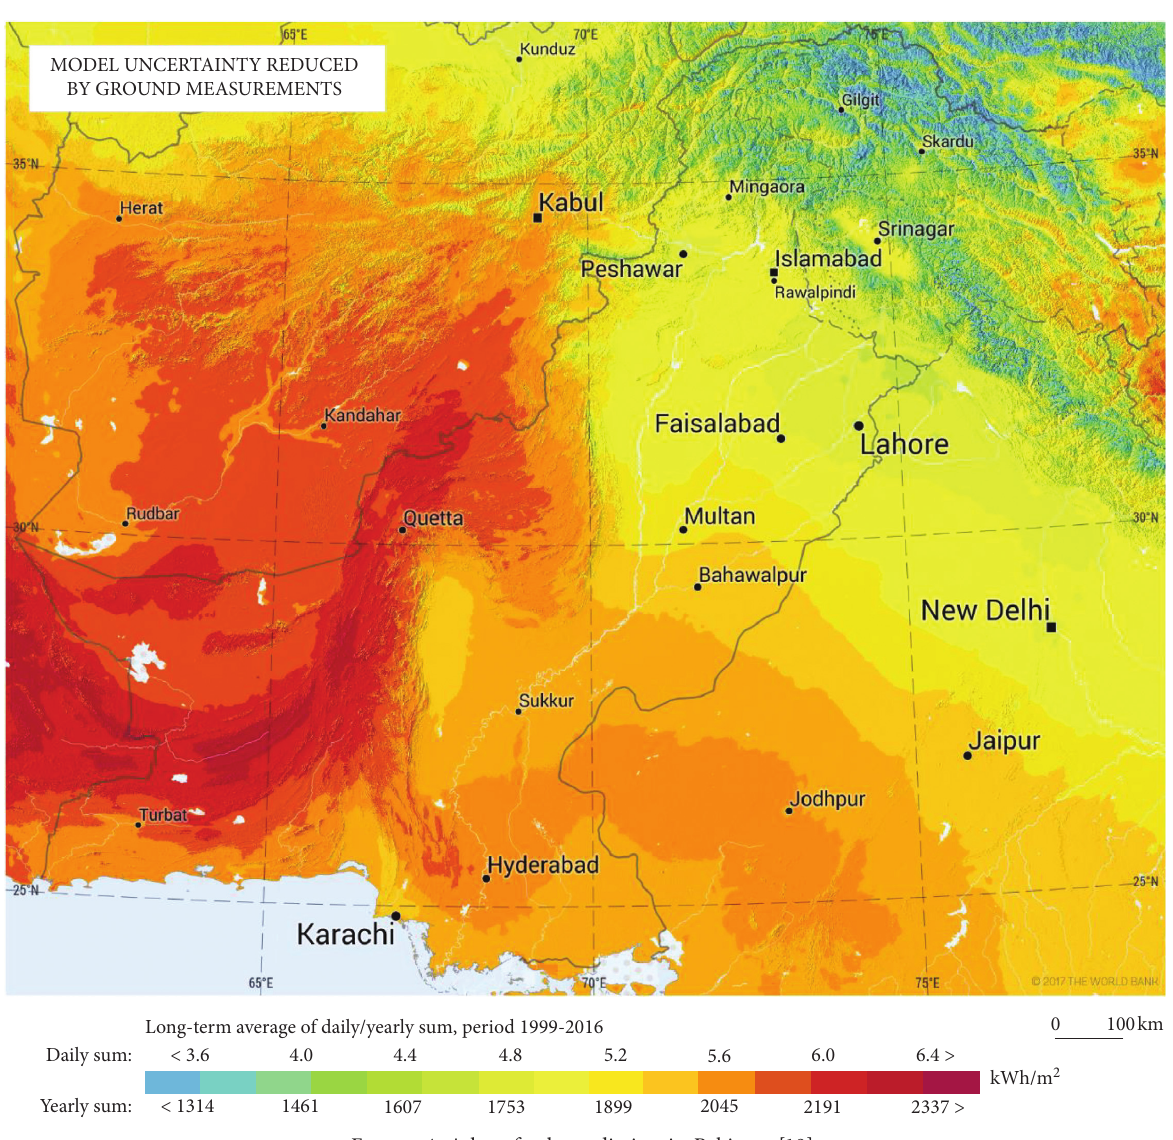
Figure 4: Atlas of solar radiation in Pakistan